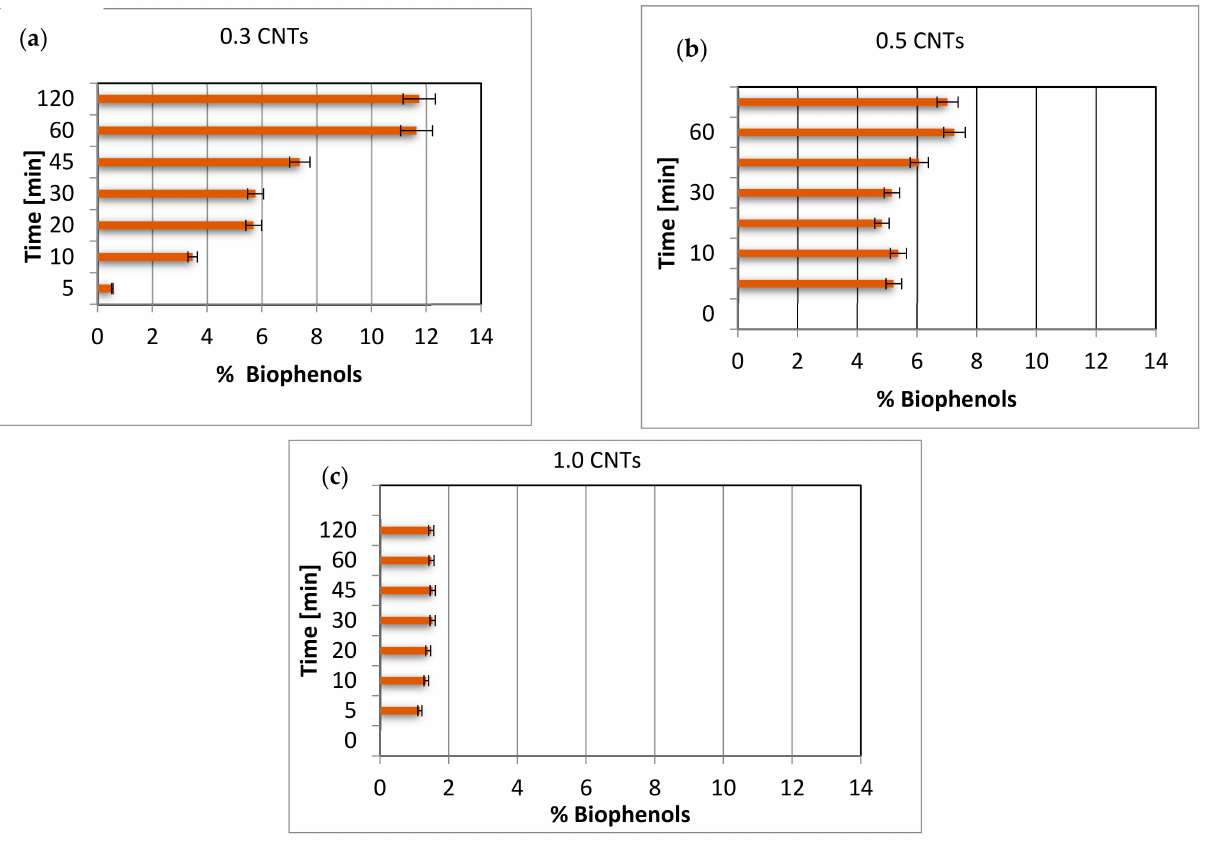
Figure 5. Percentage of biophenols with respect to the total adsorbed mass for systems with ( a ) 0.3, ( b ) 0.5, ( c ) 1.0 g of carbon